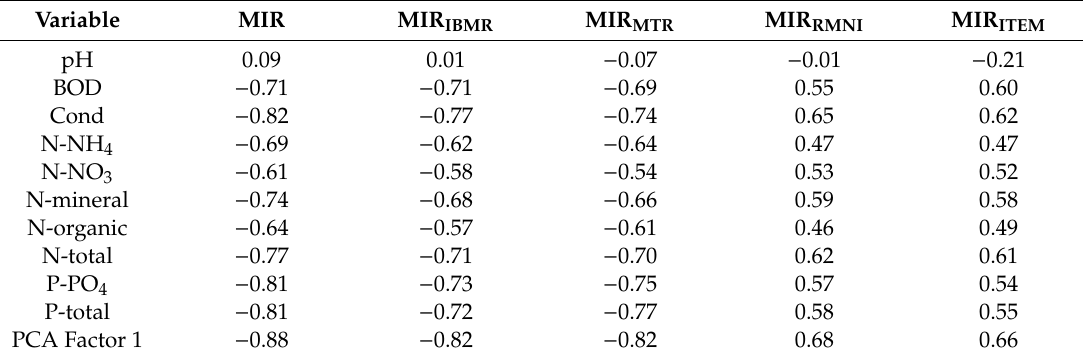
Table 8. Comparison of Pearson’s correlation coe ffi cients (r) between various environmental variables and the MIR index based on original indicative species values (MIR) and values recommended